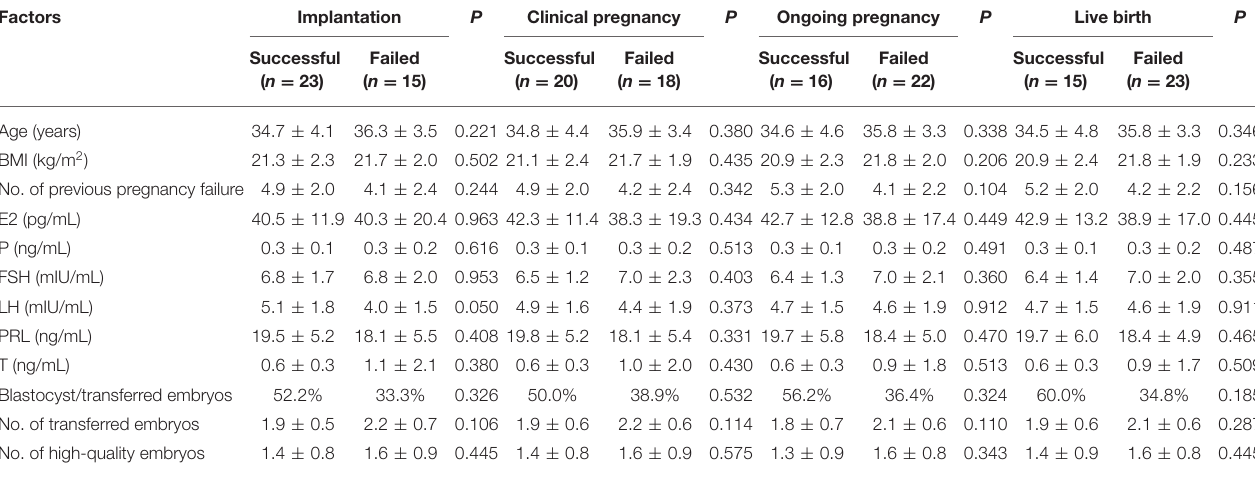
TABLE 2 | Comparison of frequency of γδ -T subsets in uRIF patients with successful pregnancy and those patients with pregnancy failure. Cell populations Implantation P Clinical pregnancy P Ongoing pregnancy P Live birth P In γδ -T cells